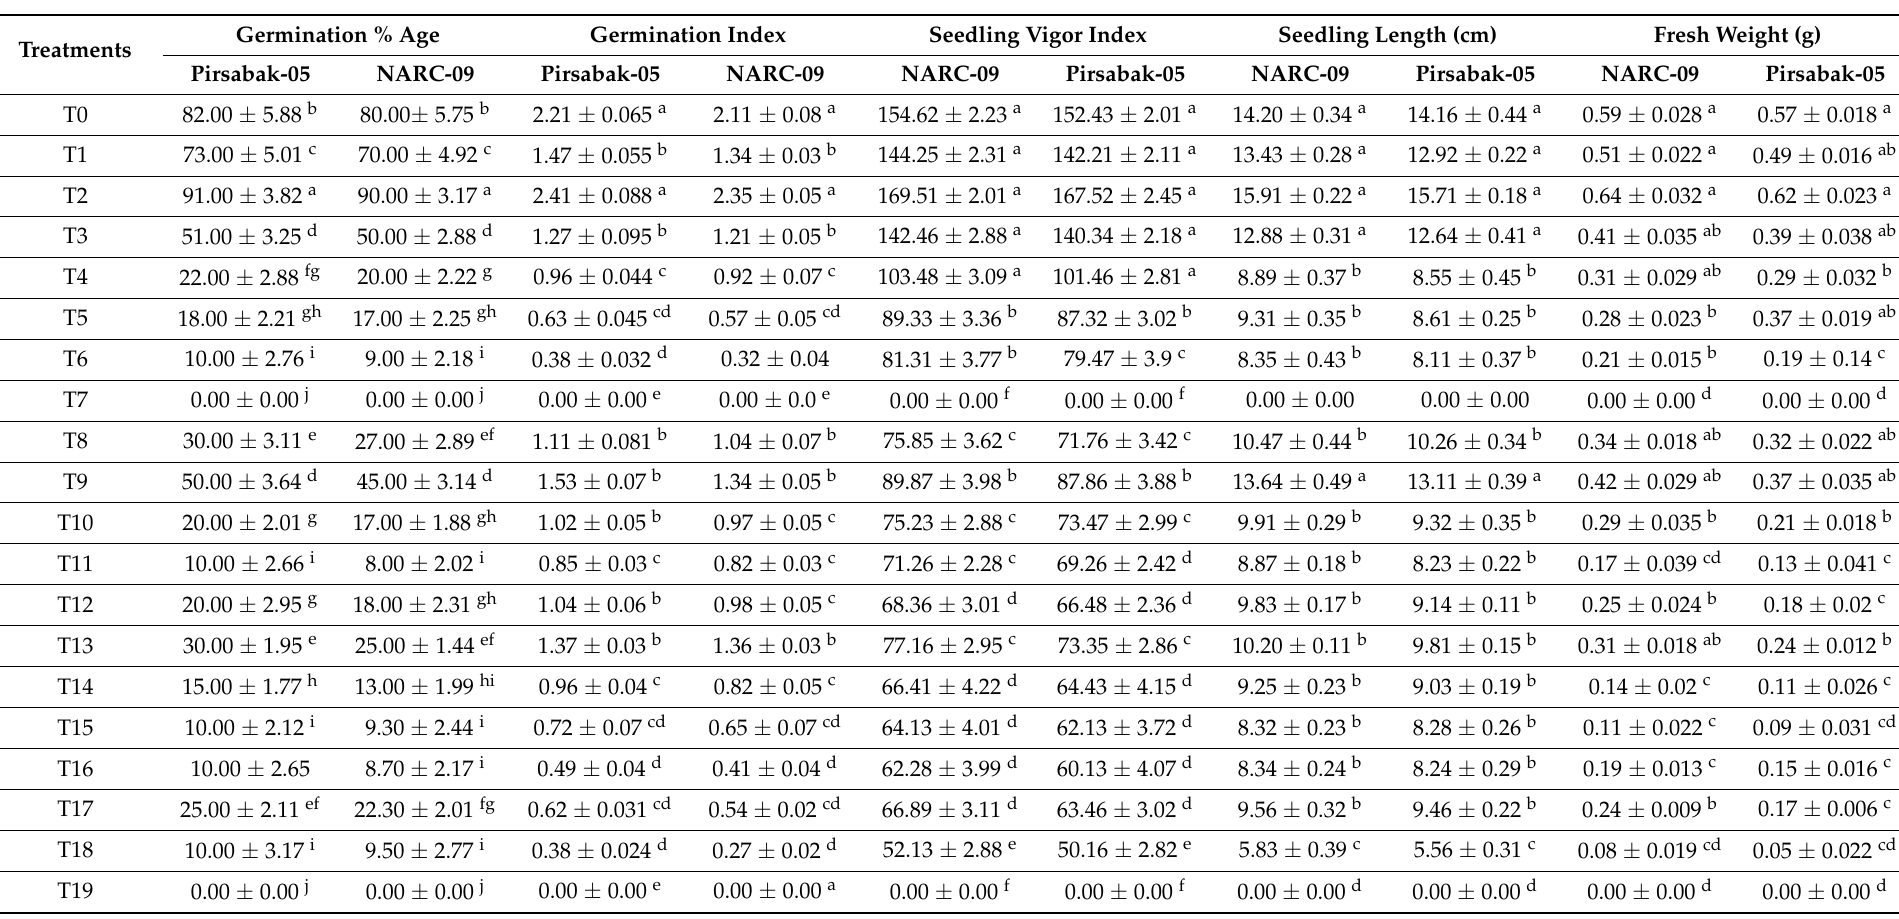
Table 2. Effects of foliar application of TiO 2 NPs (25, 50, 75, and 100 µ g/mL) on germination parameters of wheat varieties (Pirsabak-05 and NARC-09) under different salt stresses (50, 100, and 150 mM NaCl)